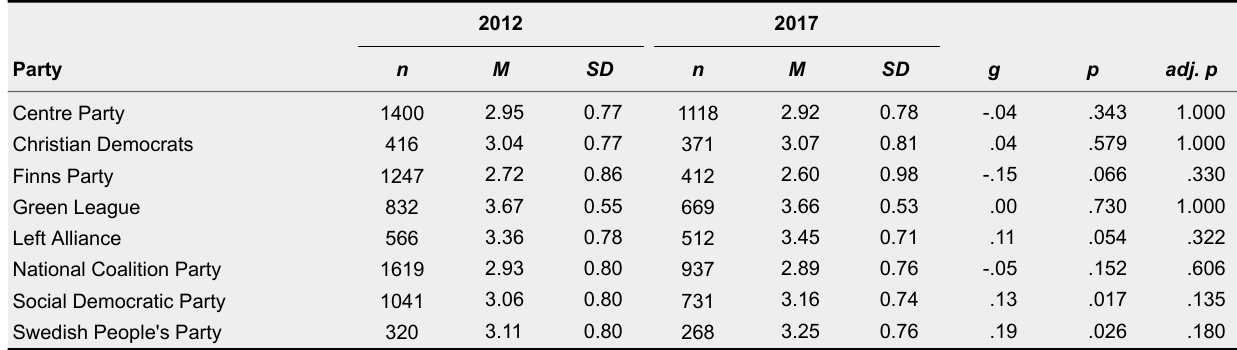
Party-Specific Descriptive Statistics and Standardized Mean Differences in Preservation of the Natural Environment Between Newcomers